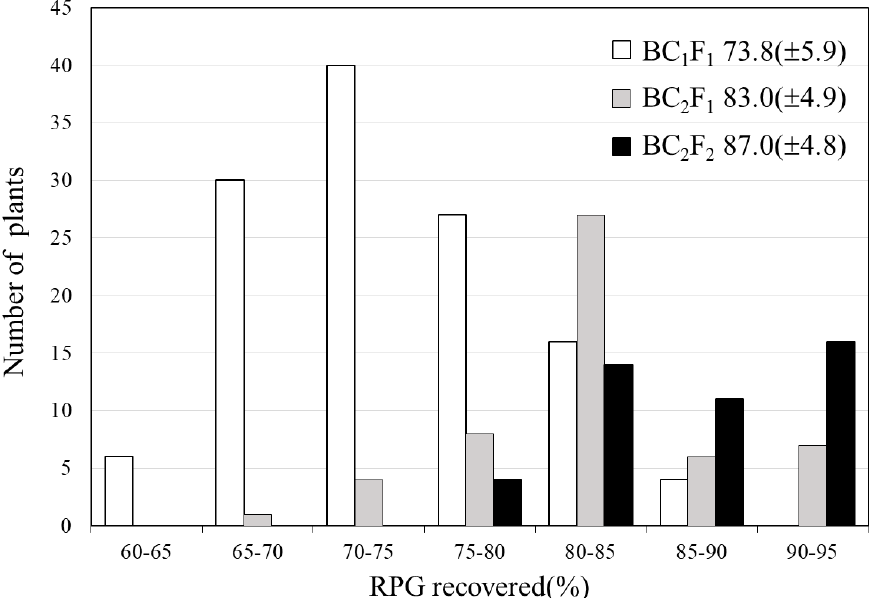
Figure 2. The frequency distribution of recurrent parent genome (RPG) recovered rate using marker-assisted backcrossing in BC 1 F 1 , BC 2 F 1 and BC 2 F 2 populations derived from the backcross of IRBB66 / TNG82. The numbers inside the right side of frame indicate the mean values (SD) of RPG recovered.